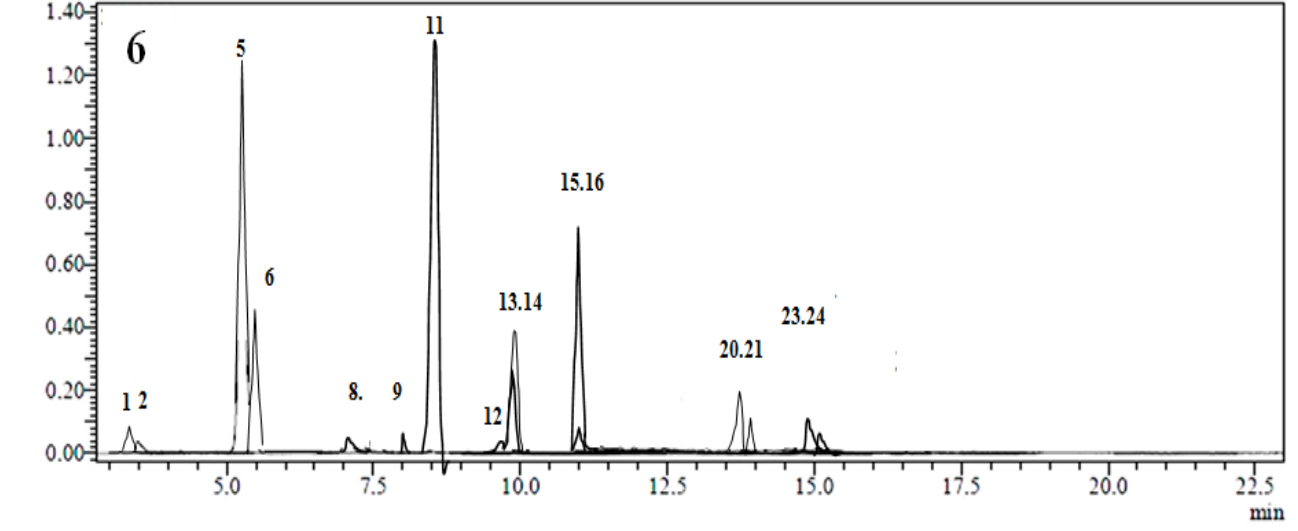
Figure 1. Chromatogram of LC – MS/MS-analyzed A. armatus extract. Table 1. LC – MS/MS data of polyphenols in A. armatus extract.